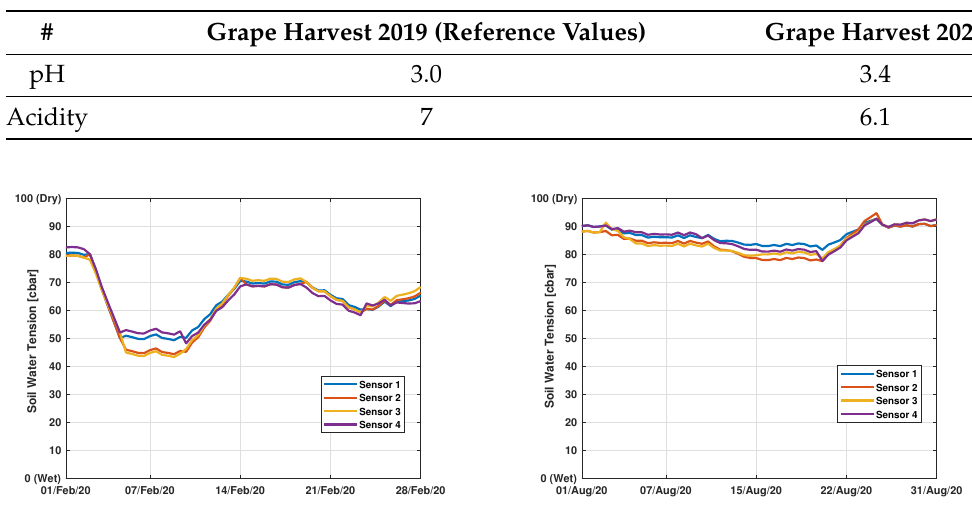
Table 4. Site 2—Comparison between relevant parameters.